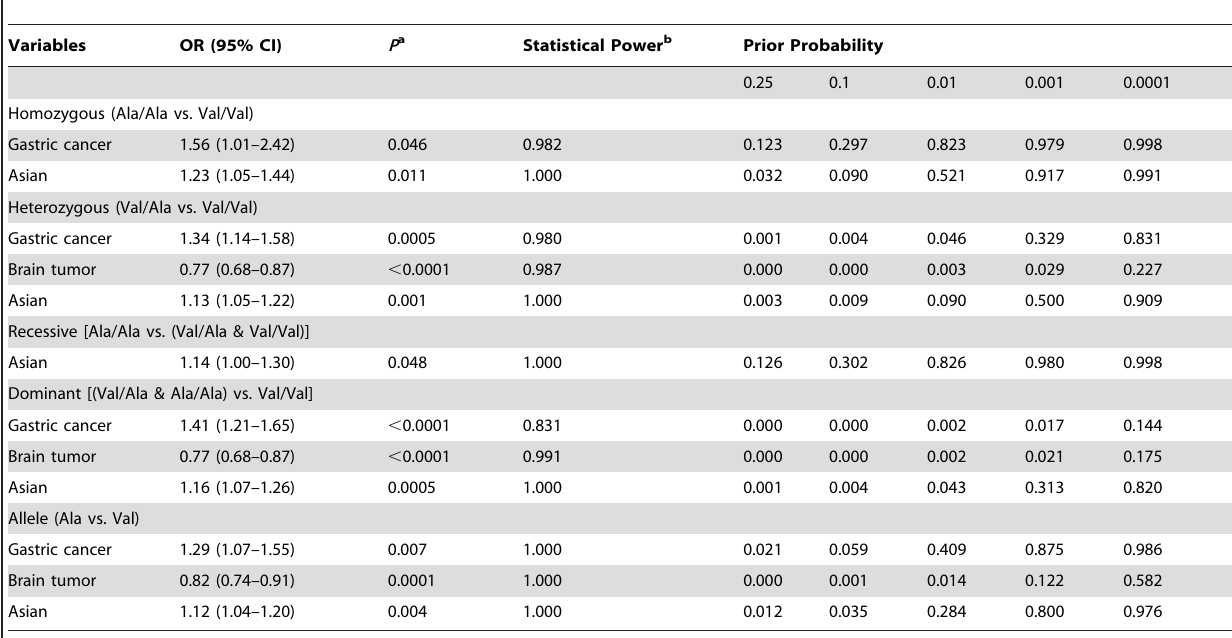
Table 3. False-positive report probability values for associations between cancer risk and the frequency of genotypes of PARP1 gene.